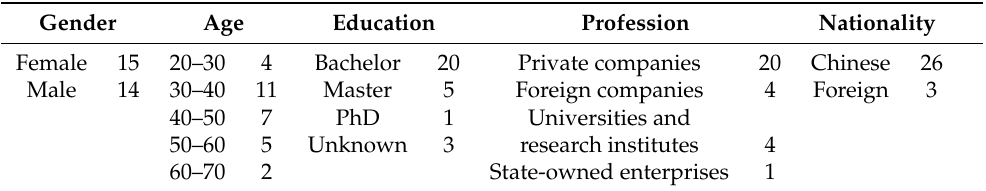
Table 1. Sociodemographic characteristics of interviewees. In terms of educational background, three interviewees preferred not to disclose the information and were thus noted as “Unknown” in the table. Regarding the professional background, one interviewee was already retired when the interview was conducted but was placed in the “University and research institute” category as she previously worked in a technical college. The three interviewees with foreign nationalities were originally from China and had worked and lived in Beijing for most of their